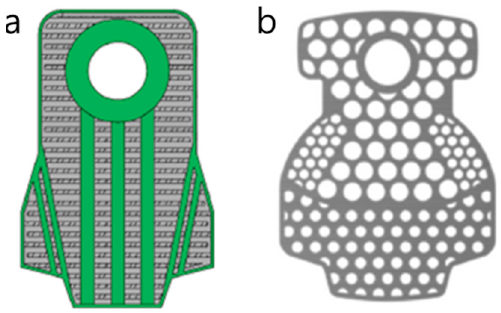
Figure 1. Schematic diagram of the GBR membranes used in this study. ( a ) 3D CAD model design of Schematic diagram of the GBR membranes used in this study. ( a ) 3D CAD the PCL/PLGA/ β -TCP membrane; ( b ) Design of pre-formed titanium mesh membrane. Guided Bone model design of the PCL/PLGA/ β -TCP membrane; ( b ) Design of pre-formed titanium mesh Regeneration (GBR). Computer-Aided Design (CAD). Polycaprolactone (PCL). Poly(lactic- co -glycolic membrane. Guided Bone Regeneration (GBR). Computer-Aided Design (CAD). Polycaprolactone acid) (PLGA). Tricalcium phosphate (TCP). (PCL). Poly(lactic- co -glycolic acid) (PLGA). Tricalcium phosphate